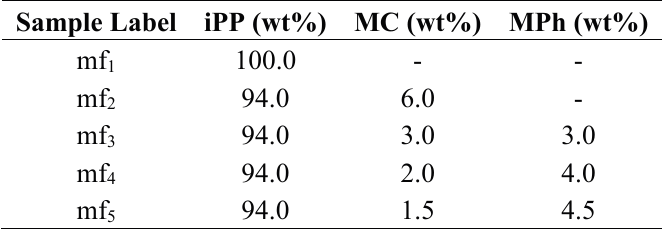
Table 1. Composition of the multifilaments used in this study.